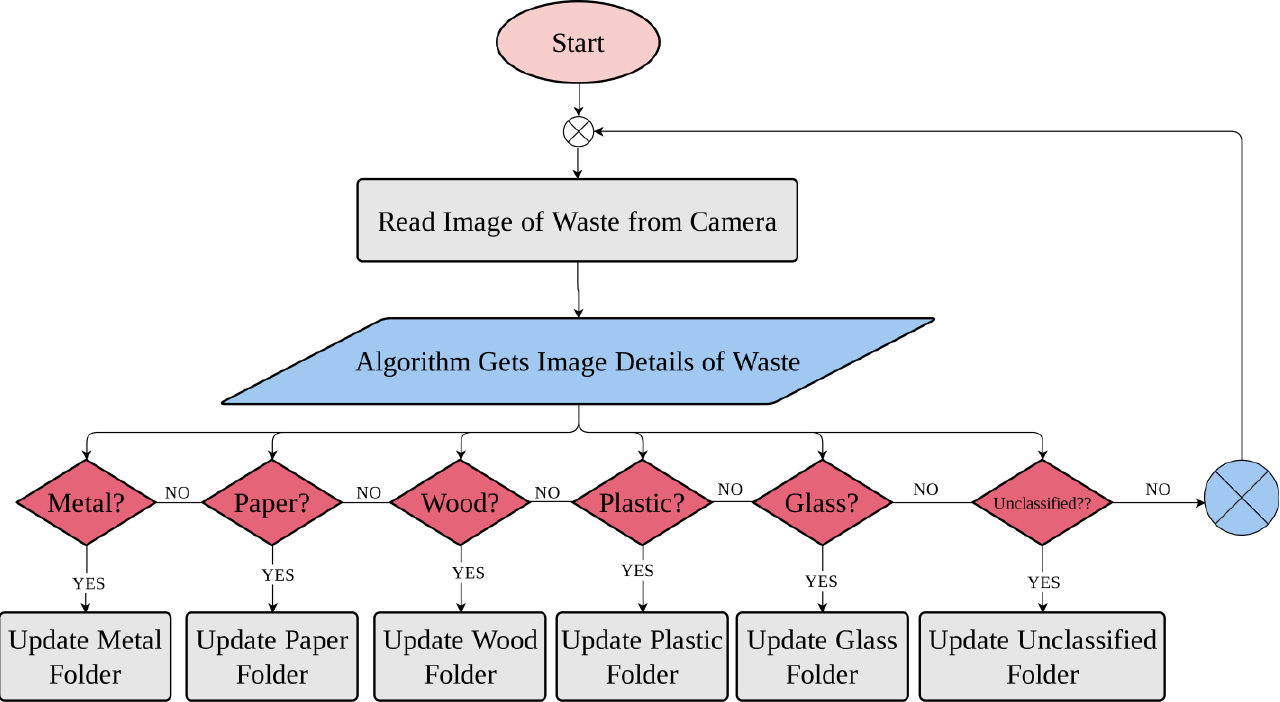
Figure 7. Flowchart of